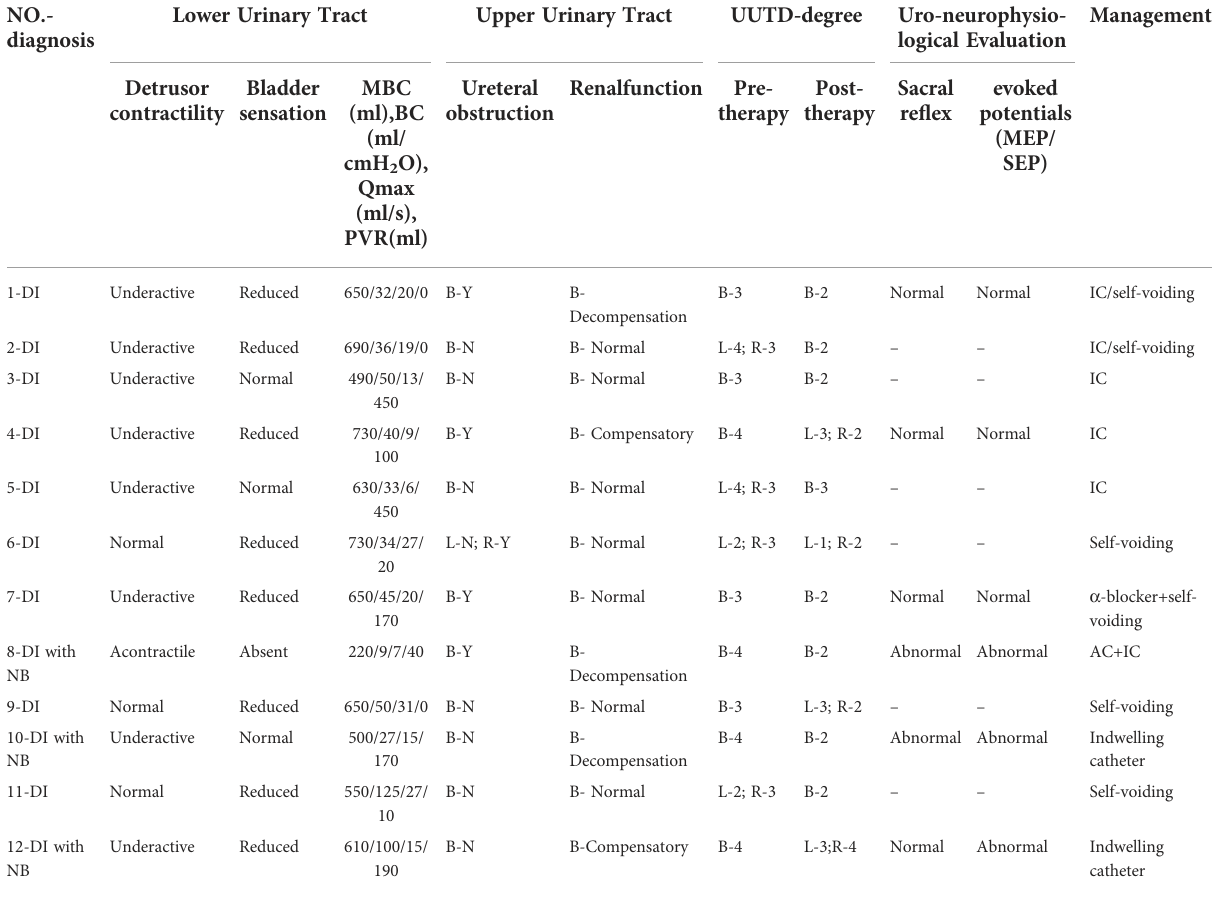
TABLE 1 The summary of UUTD and AUTD system, uro-neurophysiological evaluation and therapeutic regimens in DI patients with